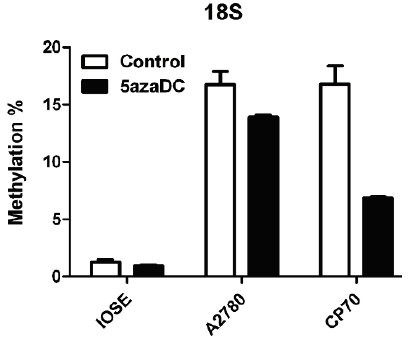
Figure 3. Treatment of ovarian cancer cell lines with 5-aza-2'-deoxycytidine (5-aza). The methylation level of ribosomal DNA (rDNA) in 18S was determined by real-time reverse transcription